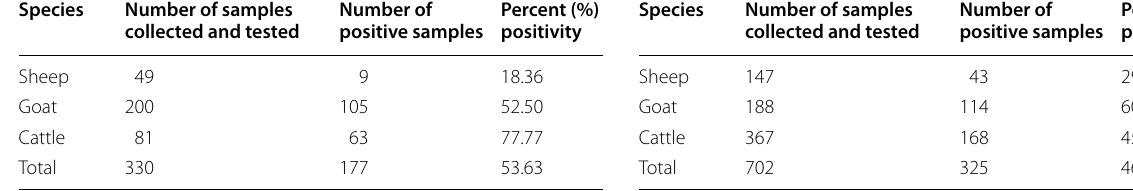
Table 5 Seroprevalence of anti-BTV antibodies among Sikkim animals Species Number of samples collected and tested